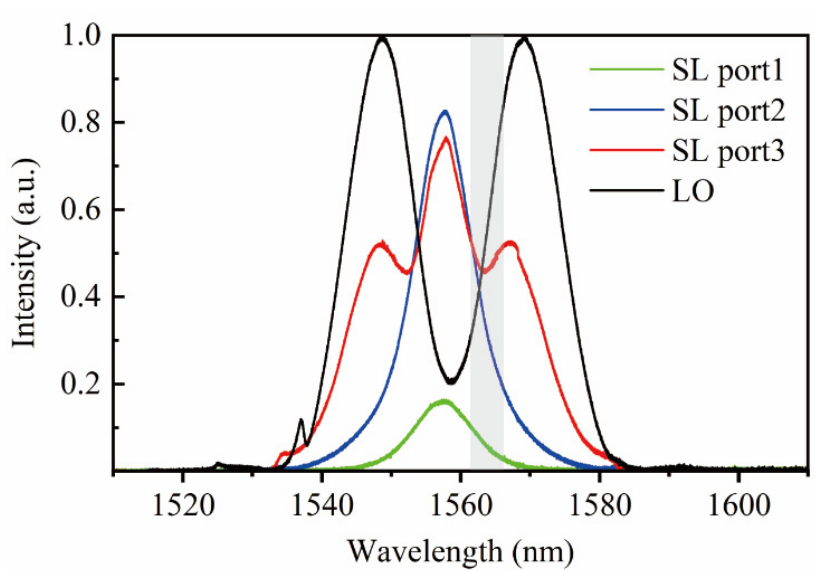
Figure 3. Optical spectrum of lasers (the passband of the filter is represented by the gray area).